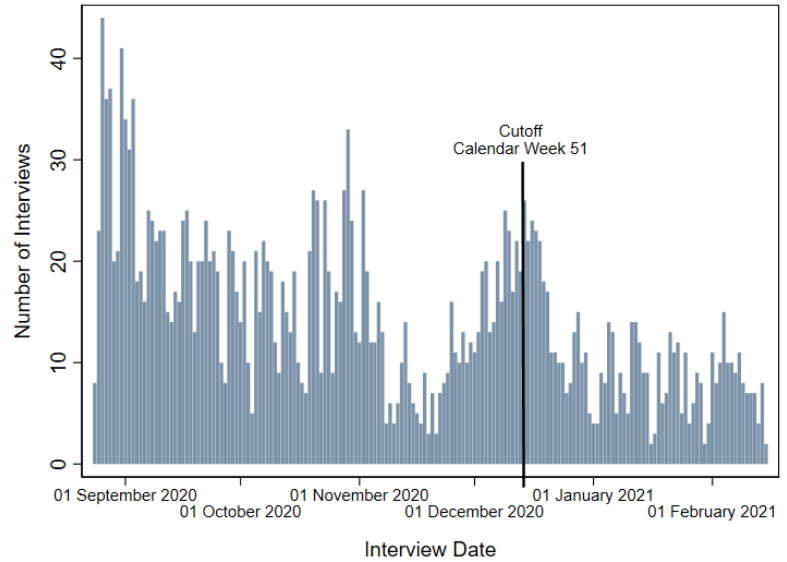
Figure 3. Interviews of the IAB-BAMF-SOEP survey wave 5 conducted in 2020. The interview period in 2020 extended from the 24th of August 2020 until the 15th